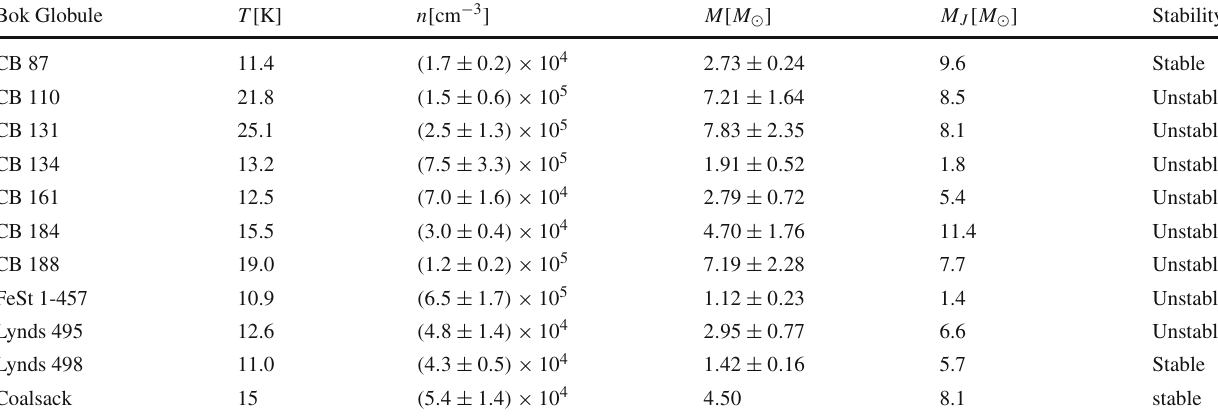
Table 1 Kinetic temperature, particle number density, mass, Jeans mass, and observed stability for several Bok globules [38] Bok Globule T [K] n [ cm − 3